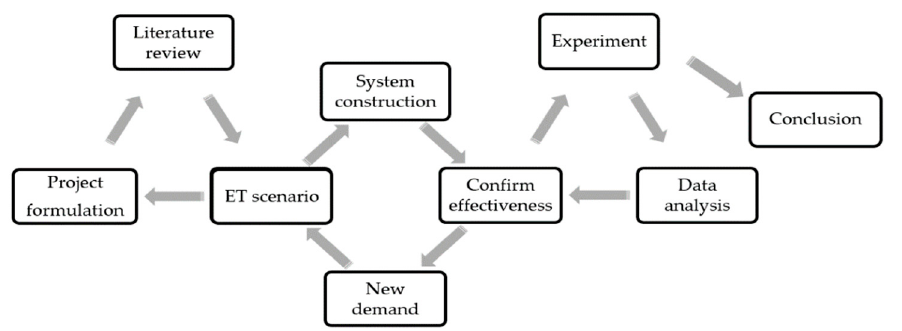
Figure 1. The iterative processes of virtual reality exposure therapy (VRET) design, development, verification, and refinement.